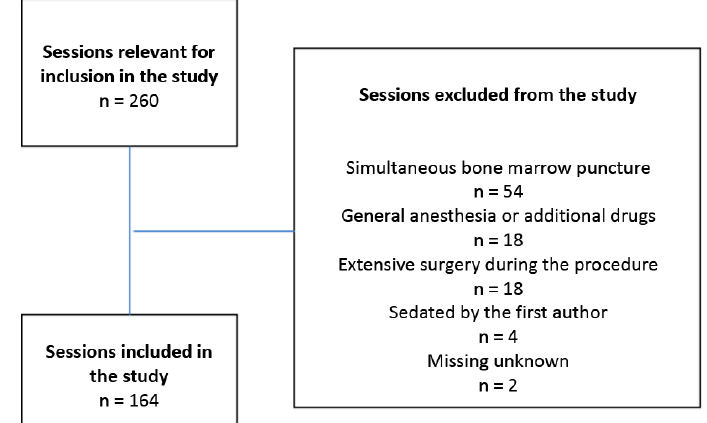
Figure 1. Selection process of sessions and reasons for exclusion.